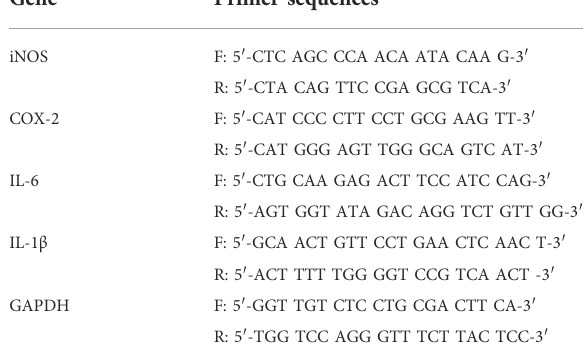
TABLE 3 Primers used in the RT-qPCR analysis.